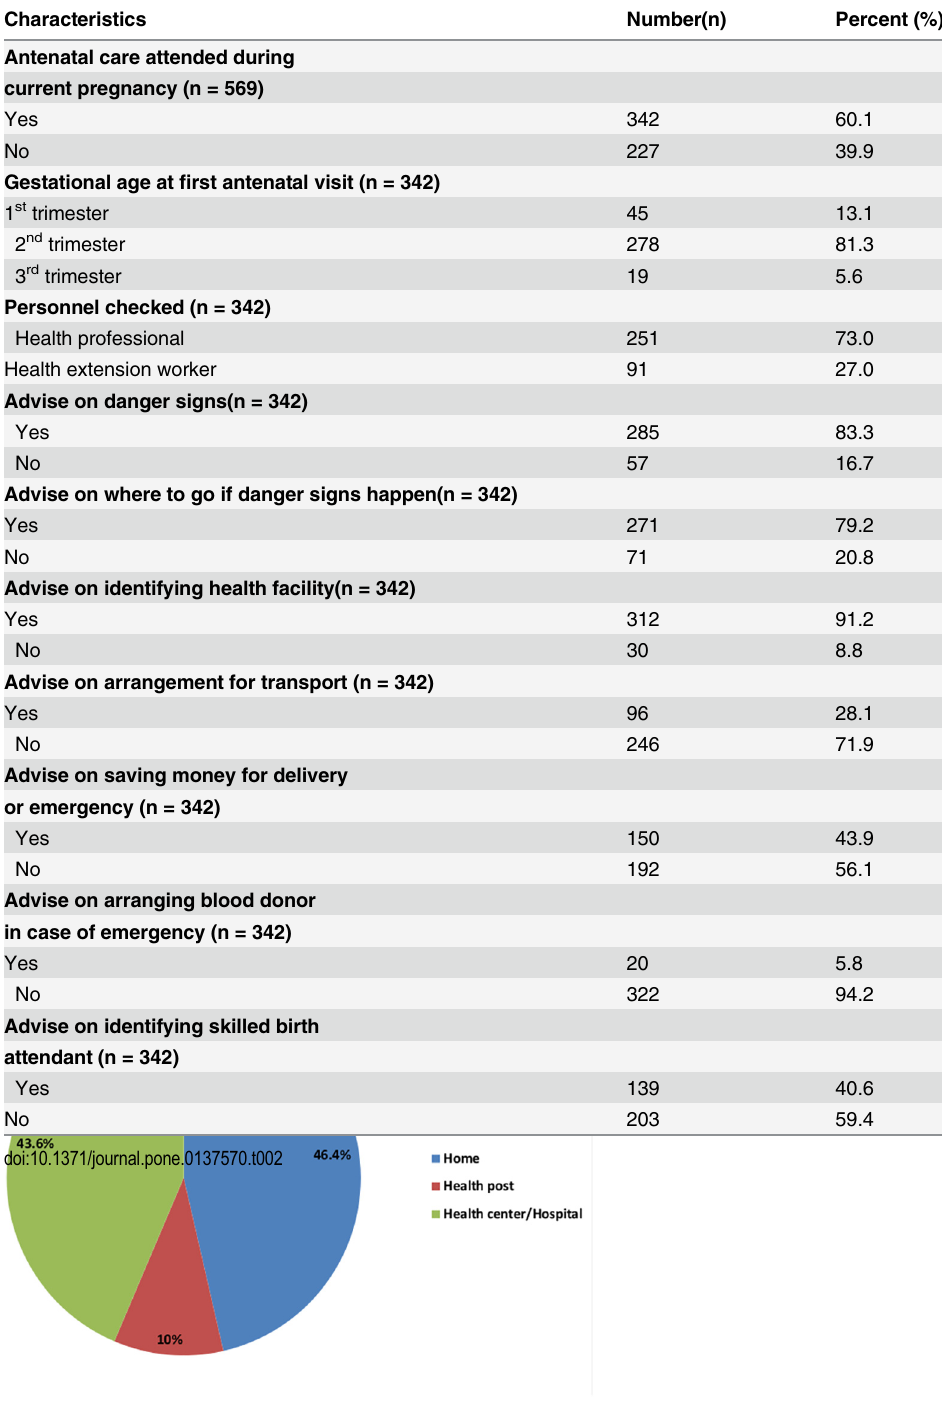
Fig 1. Expected place of delivery among pregnant women in Duguna Fango District, 2013.This figure shows planned for place of delivery among pregnant women in Duguna Fango District. Two hundred sixty four (46.4%) of pregnant women planned to give birth at home, 248 (43.6%) pregnant women planned health center/ hospital birth and 57 (10%) of respondents planned health post for child birth.